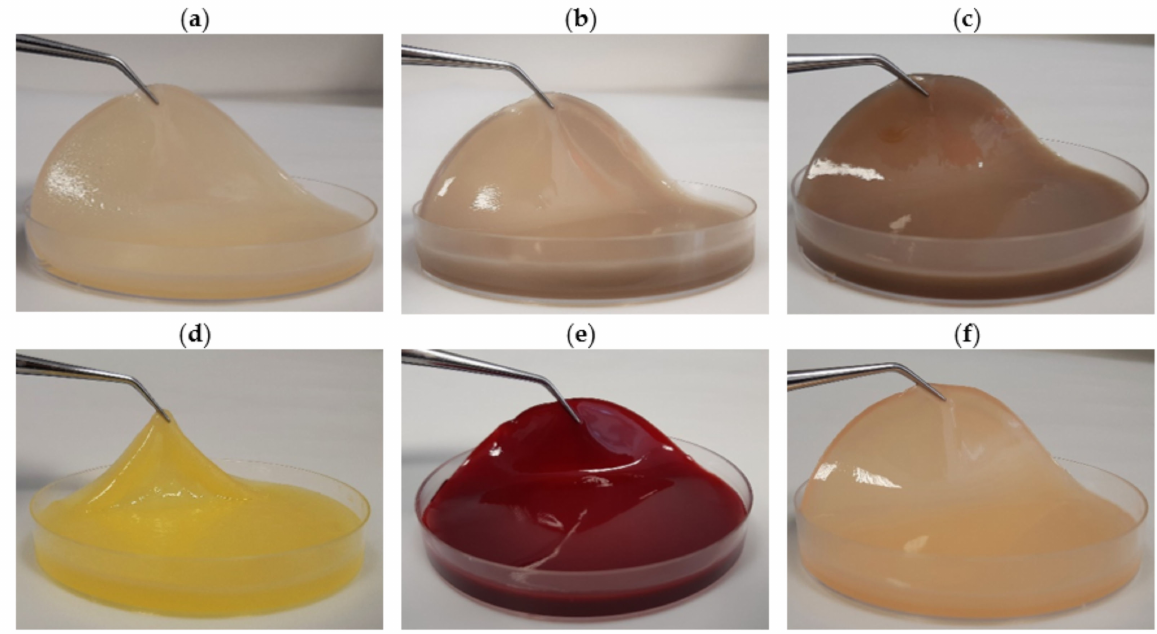
Figure 5. BC obtained from K. xylinus ATCC 53524 using ( a ) HS and natural ingredients-based media prepared from ( b ) potato juice, ( c ) potato peels, ( d ) orange peels, ( e ) beetroots, and ( f )